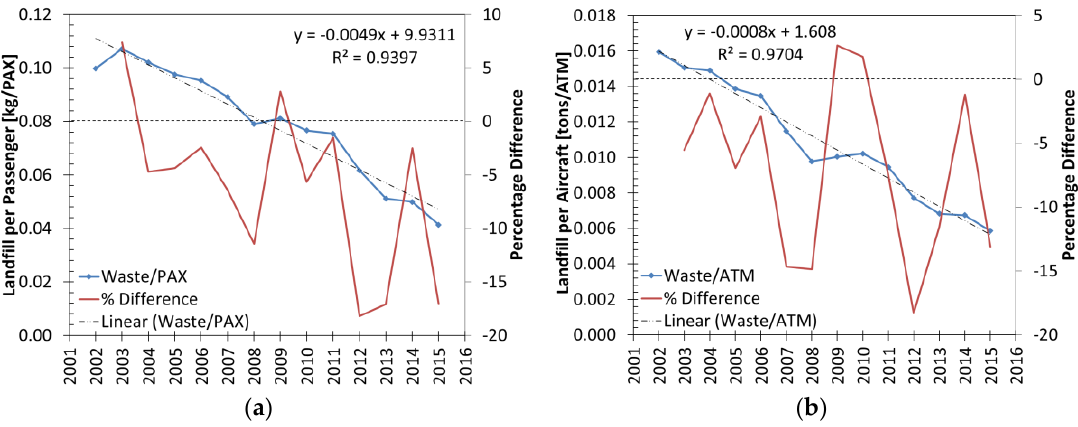
Figure 7. Landfill waste and year on year percentage difference at Kansai International Airport during 2002–2015: ( a ) per passenger; and ( b ) per aircraft movement. Source: Data derived from [60,66].